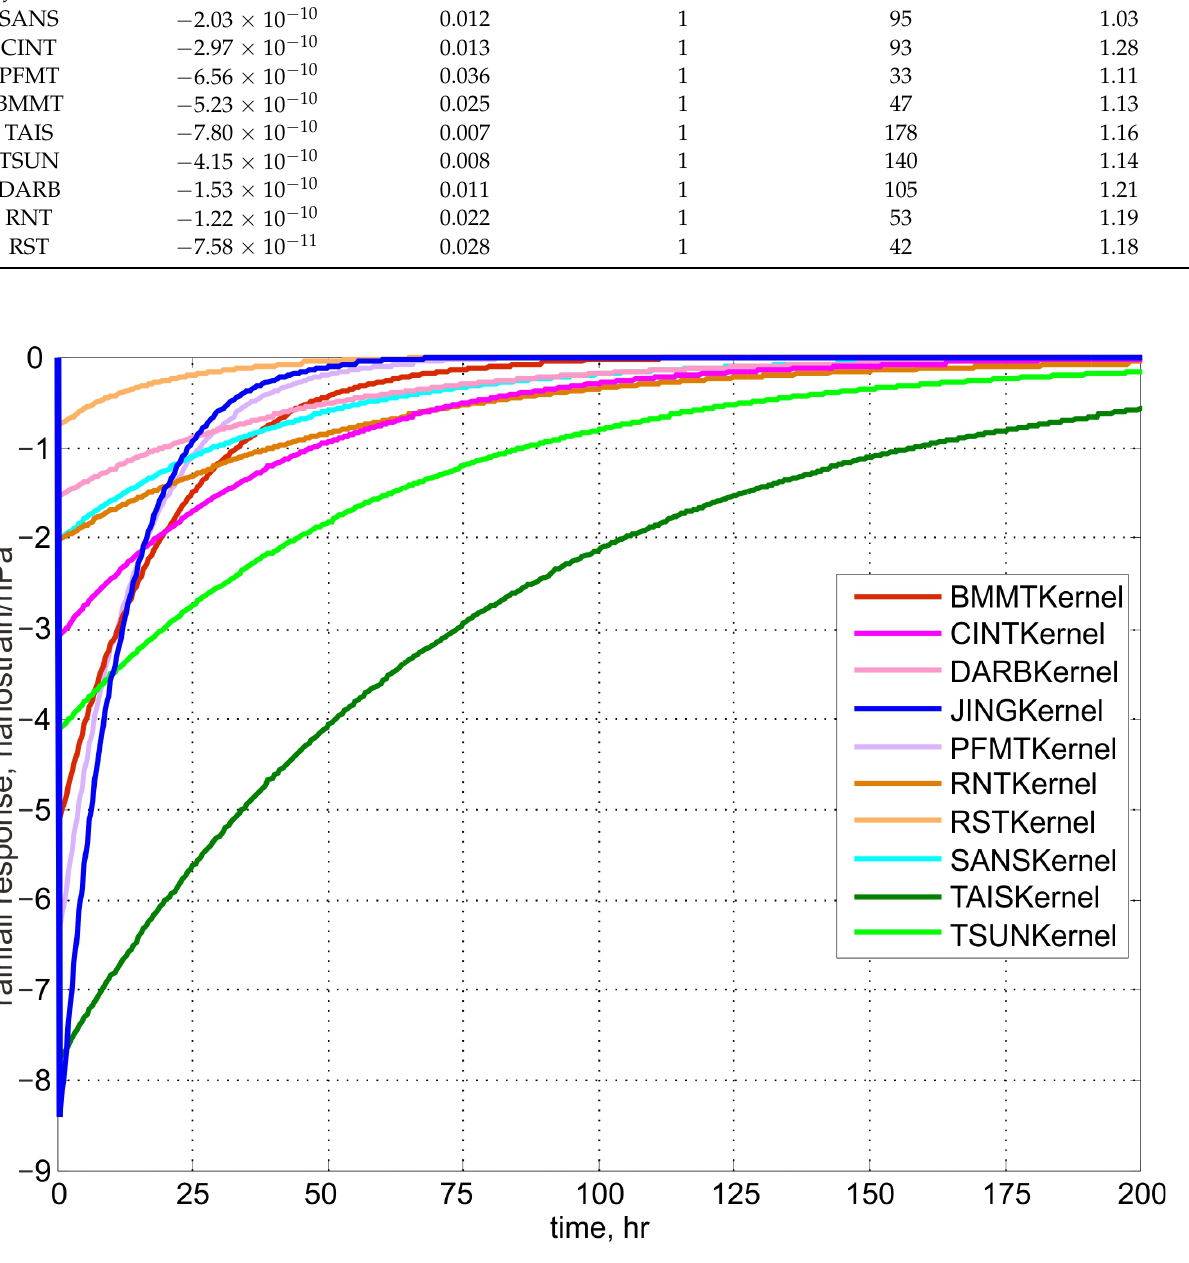
Figure 6. The kernel curves of all BSMs plotted on the same scale diagram.